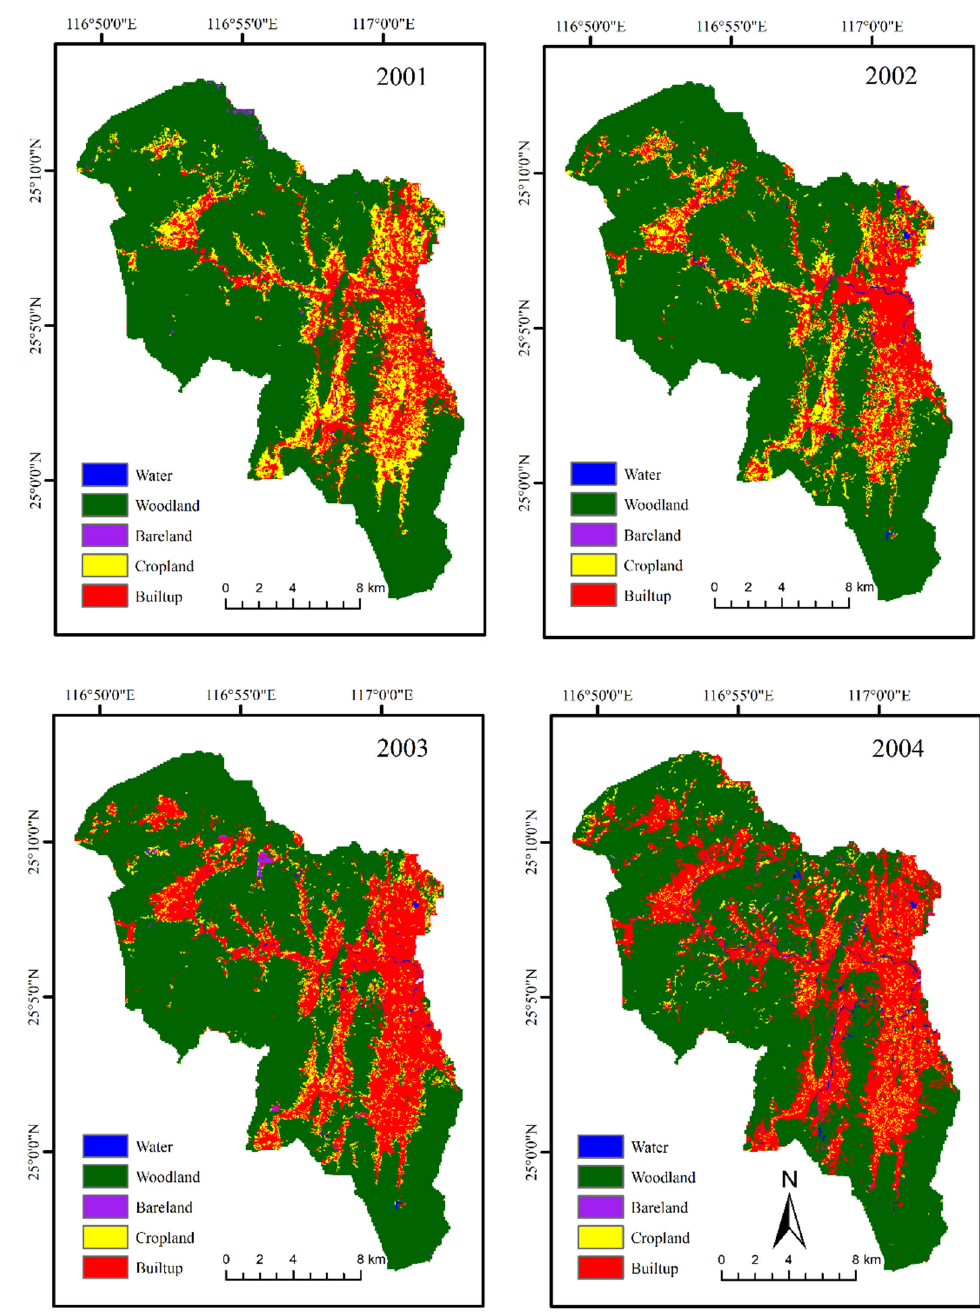
Figure 4. Maps of land categories in the L–S Creek watershed during 2001–2004.